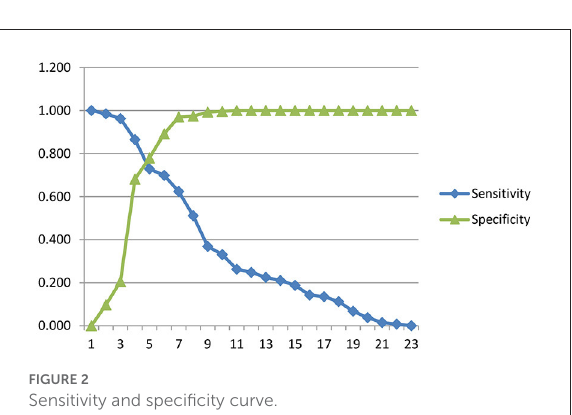
FIGURE2 Sensitivity and specificity